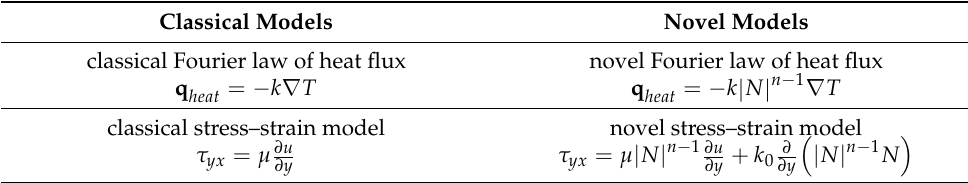
Table 1. Comparison between classical and novel